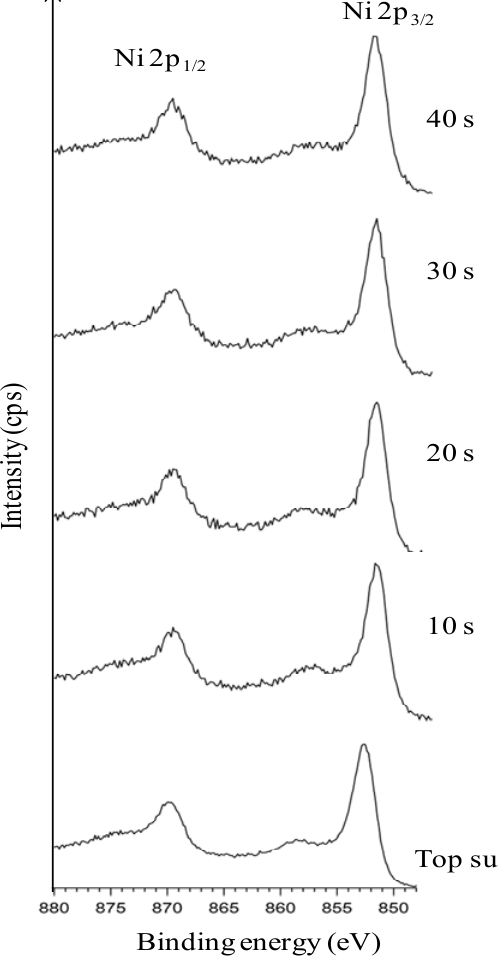
Figure 13. XPS depth profile studies of Ni peaks after chemical cleaning with etching for 15 min followed by thermal